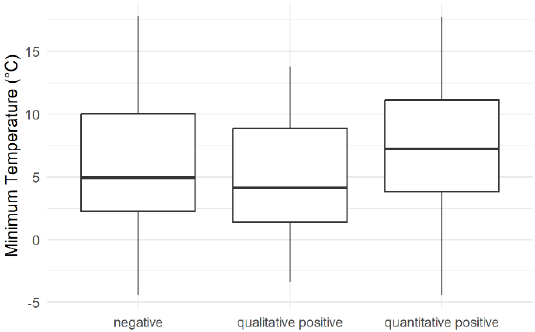
Figure 3. Association of minimum temperature with the occurrence of Campylobacter spp. on teat skin ( Campylobacter spp. negative, qualitatively positive (enrichment) and quantitatively positive teat swab samples). The black line indicates the median temperature, and the boxes display the interquartile range.